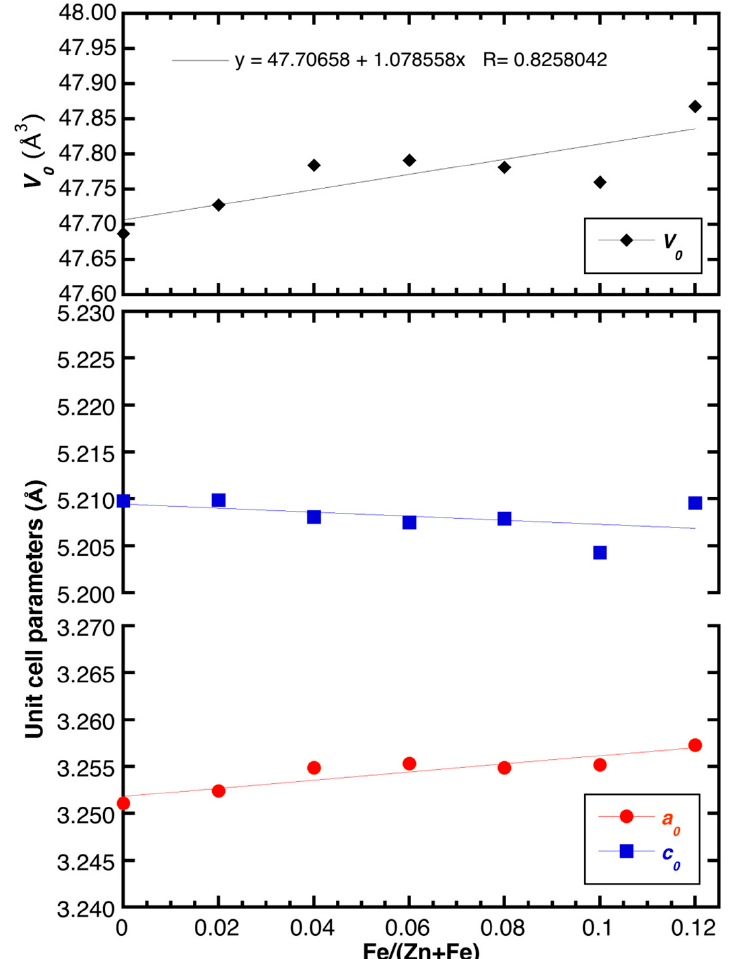
Figure 3. Refined unit cell parameters of the as synthesized samples (error bars shown within symbols) as a function of the Fe/(Fe + Zn) ratio. The linear fits for the refined data are also shown.